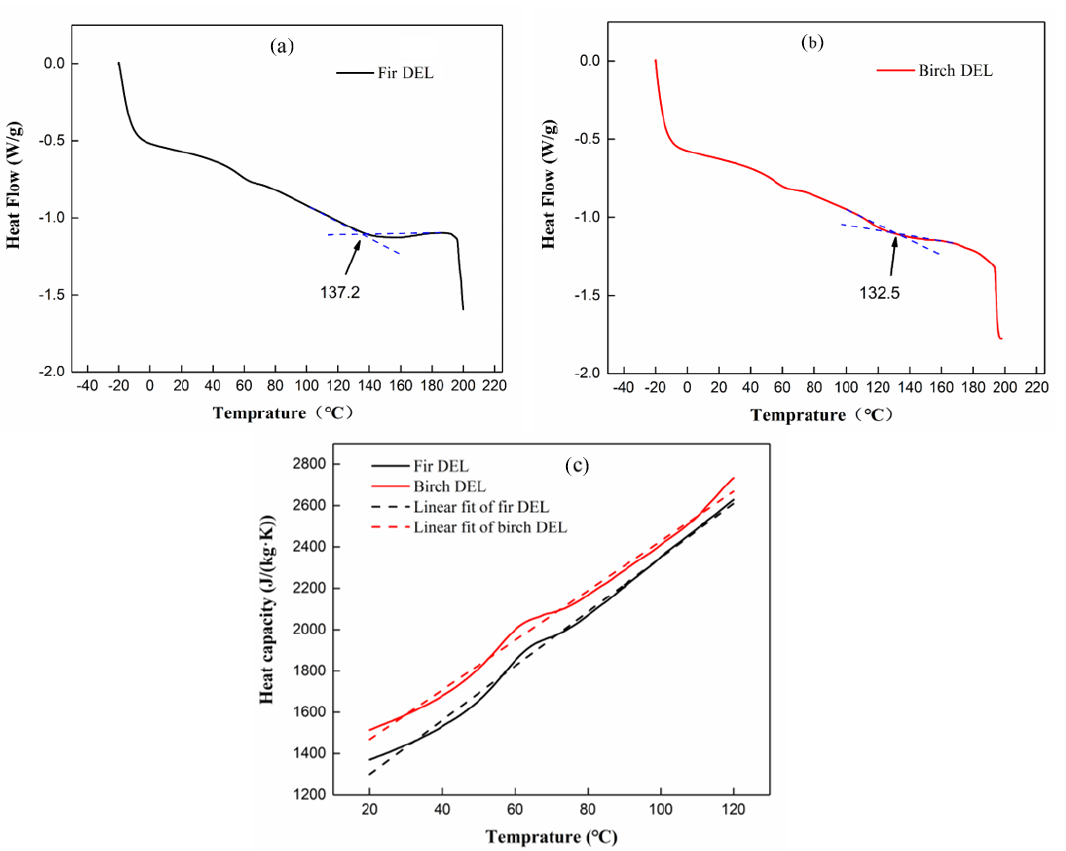
Figure 4. ( a ) Heat flow of Chinese fir; ( b ) Heat flow of birch DEL; ( c ) Specific heat capacities of Chinese fir DEL and birch DEL.